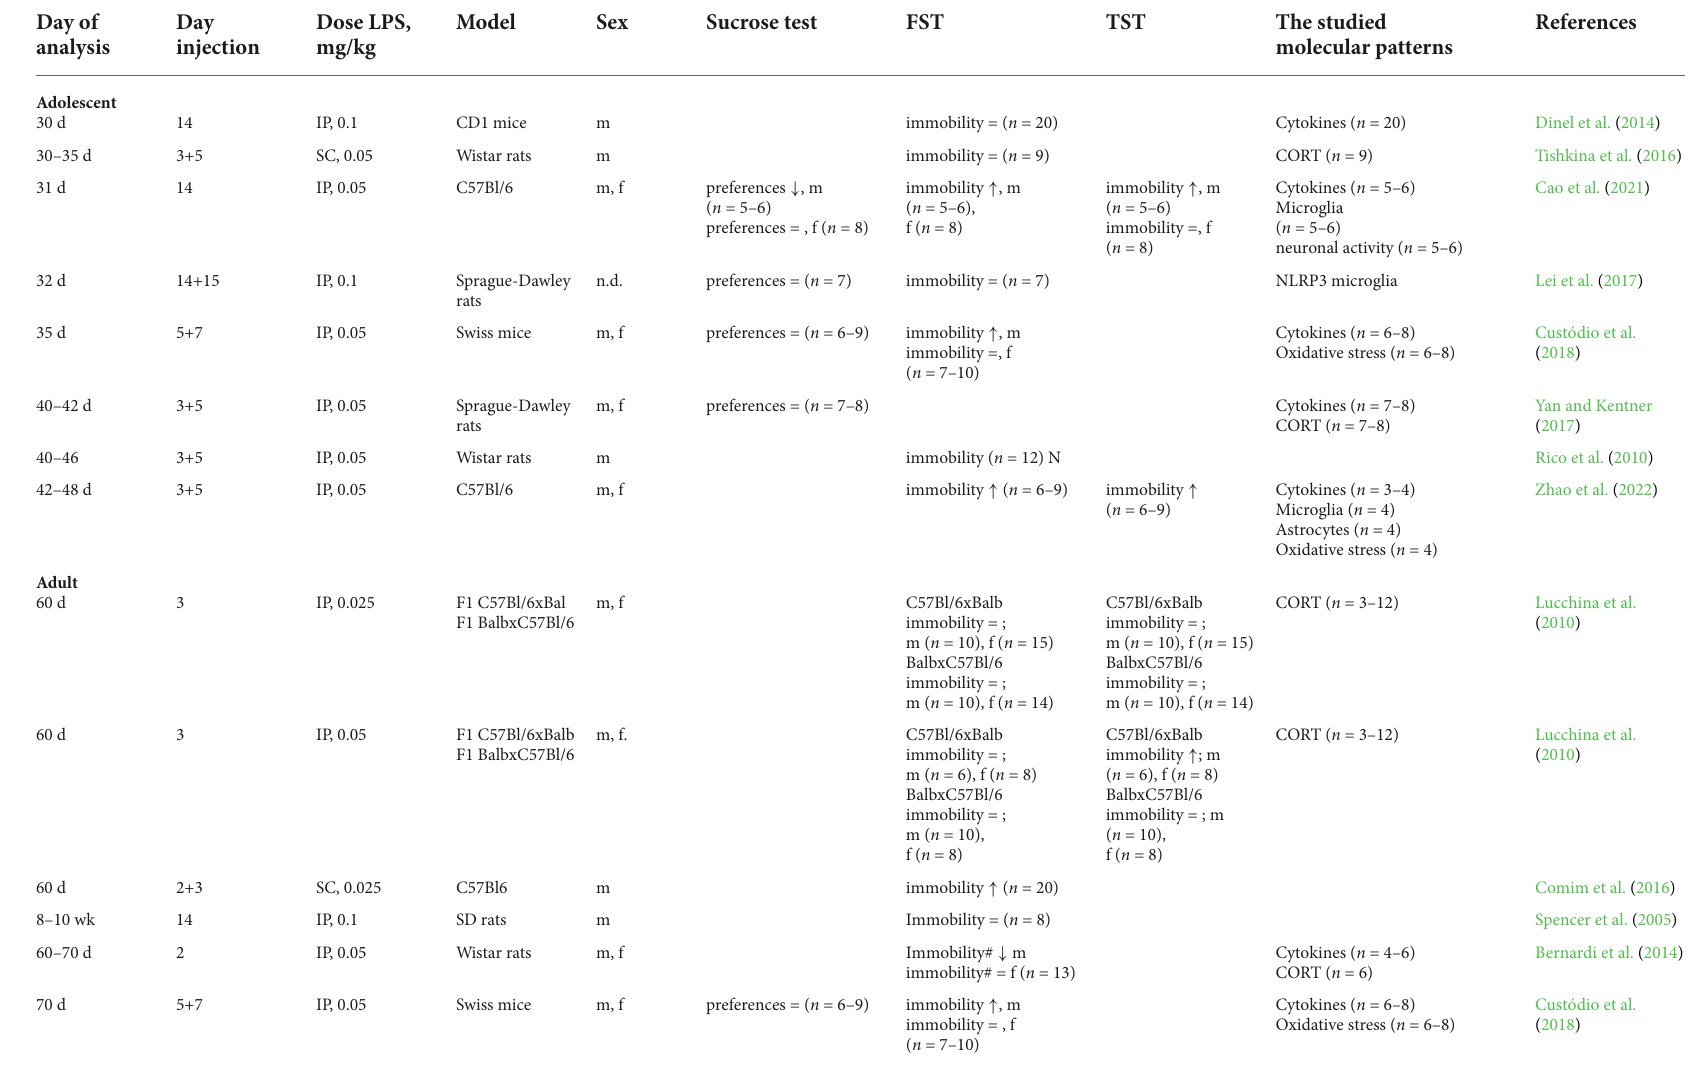
TABLE 1 Characteristics of the 25 original articles included in the